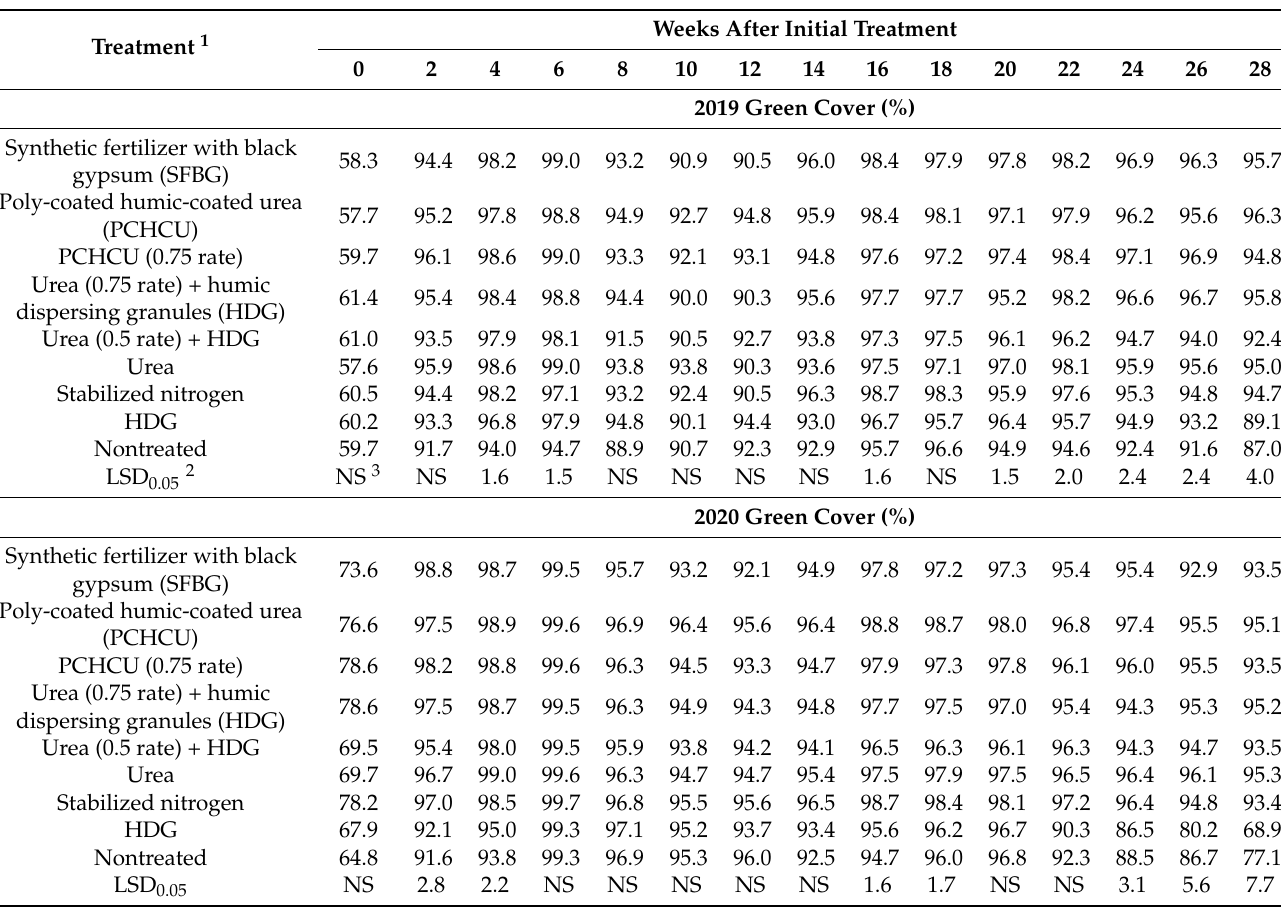
Table 4. Effects of various fertilizers on percent green cover, determined by digital image analysis, of a native soil Kentucky bluegrass maintained at 7.6 cm in Ames, IA, USA in 2019 and